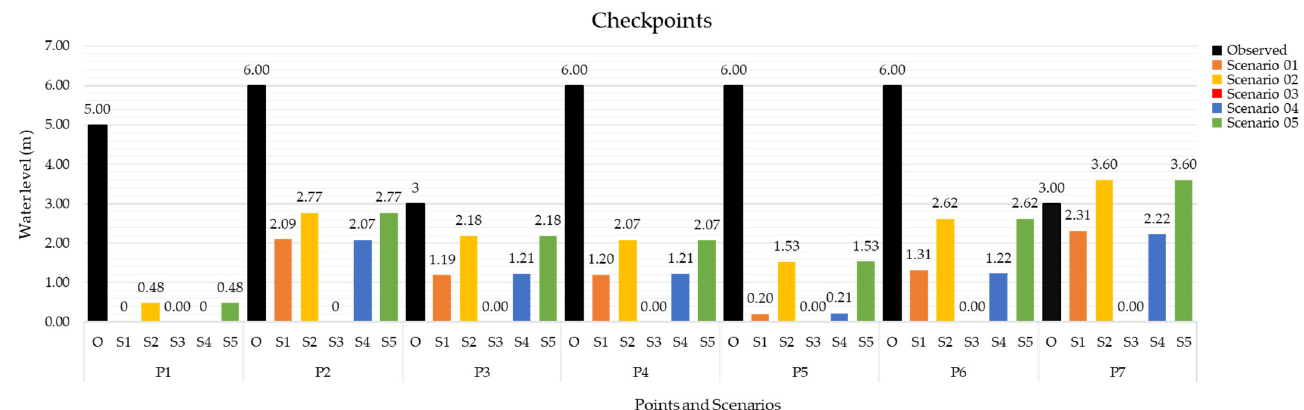
Figure 14. Checkpoints comparison of the water levels between observed and simulated scenarios by